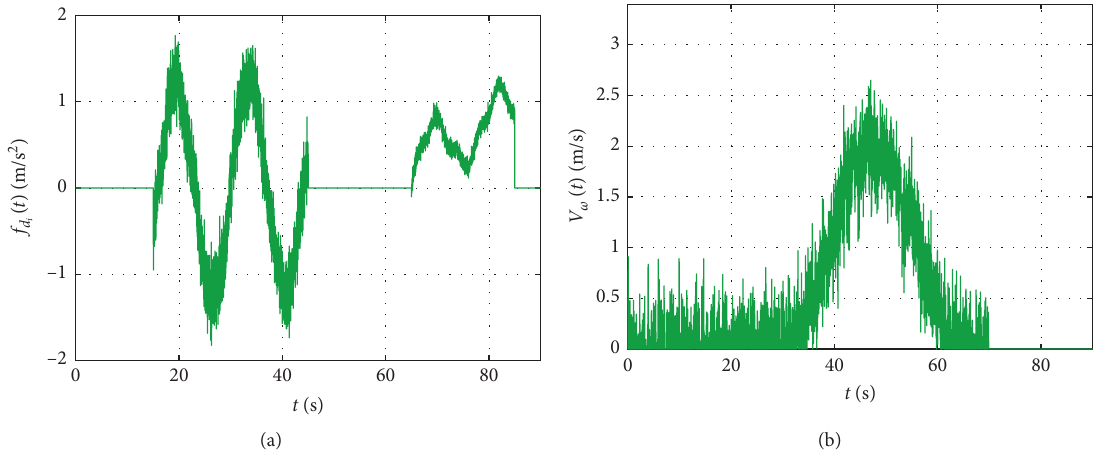
Figure 6: Wind disturbance representations. (a) Disturbance for i � x ; y ; z , case 1. (b) Wind speed model, case 2.